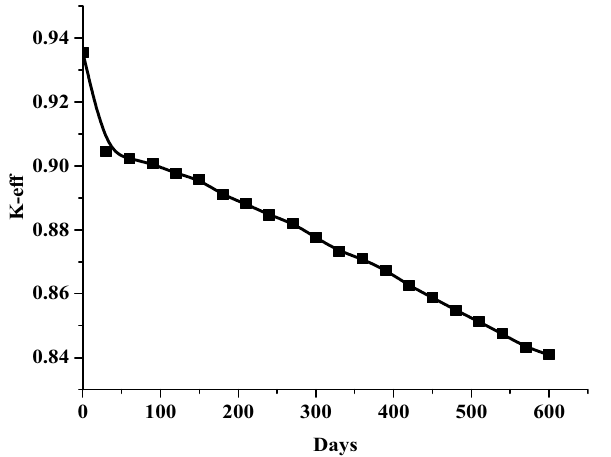
Figure 19. K-effective results for 20 months burn with 2 week time steps.